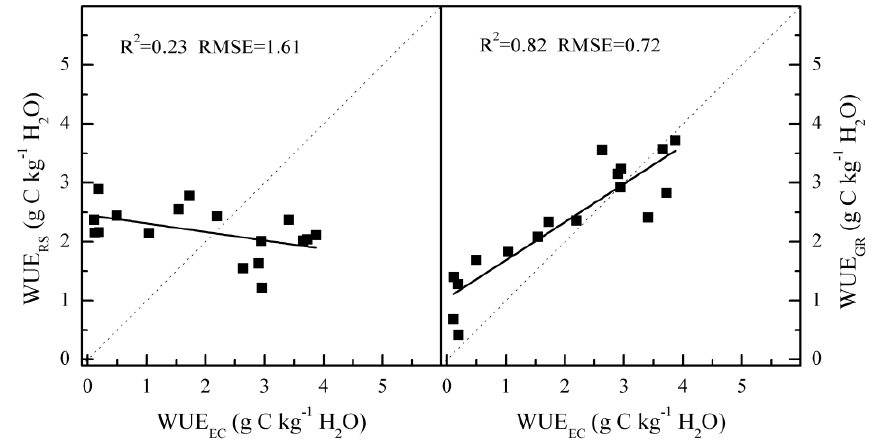
Figure 8. A linear comparison between ecosystem WUE from flux tower measurements (WUE EC ) with predictions from MODIS products (WUE RS ) and estimates based on MODIS EVI data (WUE GR ), respectively at the flux tower site US-Ro1 during the growing season of 2005 (corn).